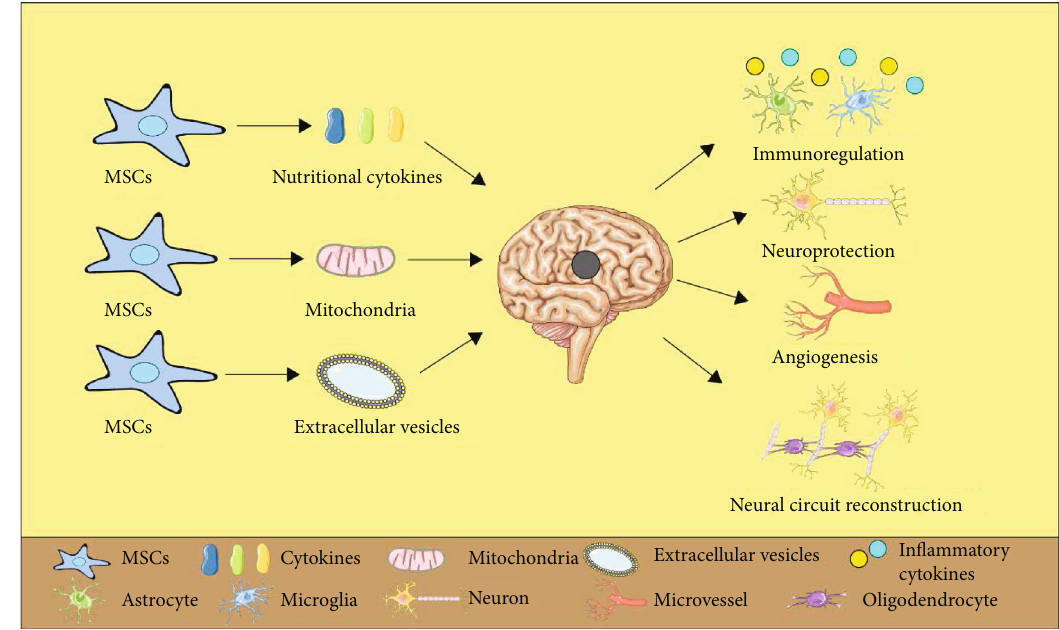
Figure 1: Mechanisms of MSCs in the treatment of IS. This fi gure contains elements available at Servier Medical Art repository, which